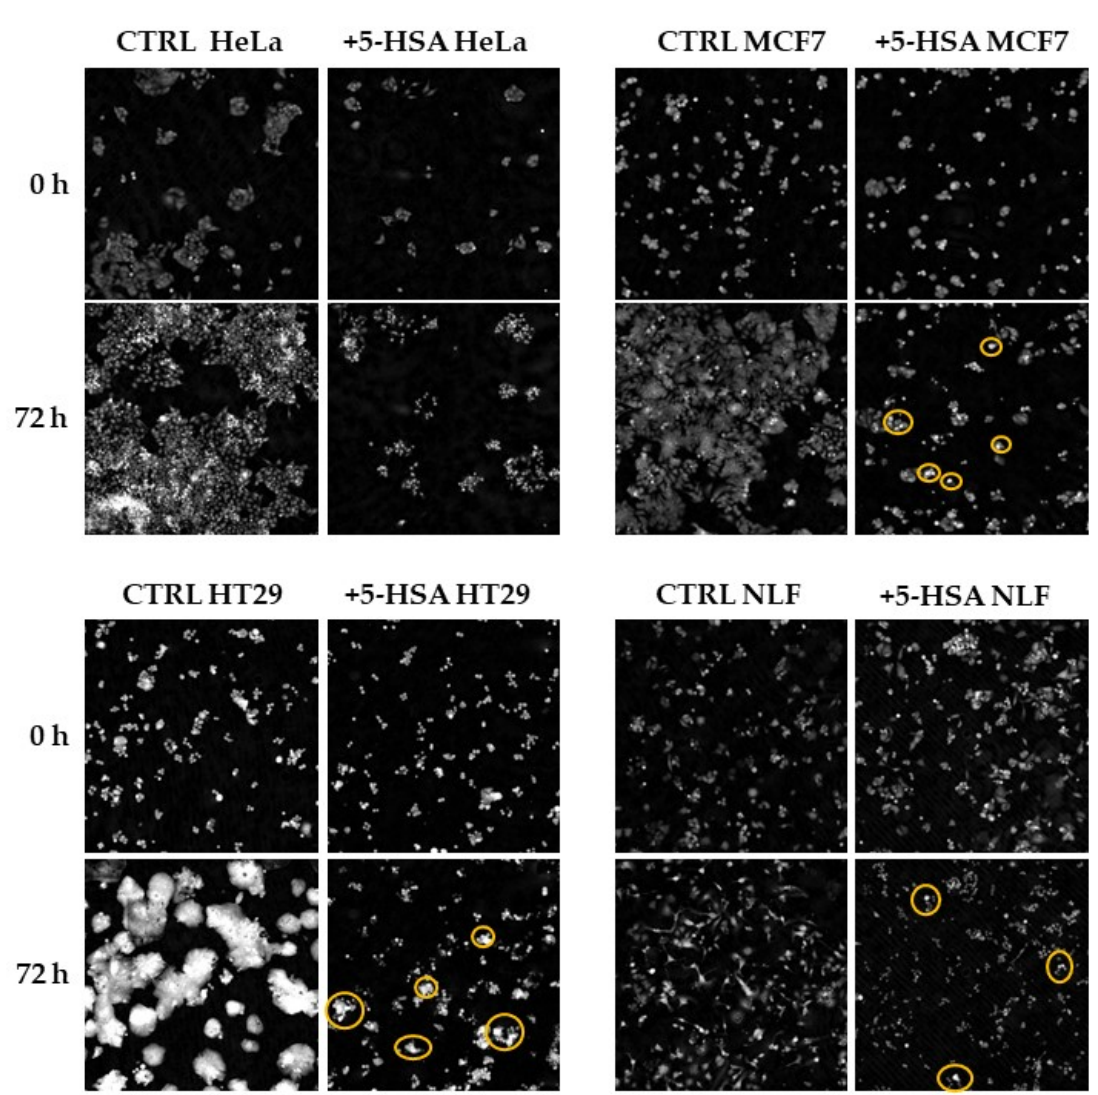
Figure 2. Quantitative phase images. Representative images at 0 and 72 h of HeLa, HT29, MCF7, and NLF control cells and treated with 50 μ M 5-HSA . Yellow circles indicate dense cells.